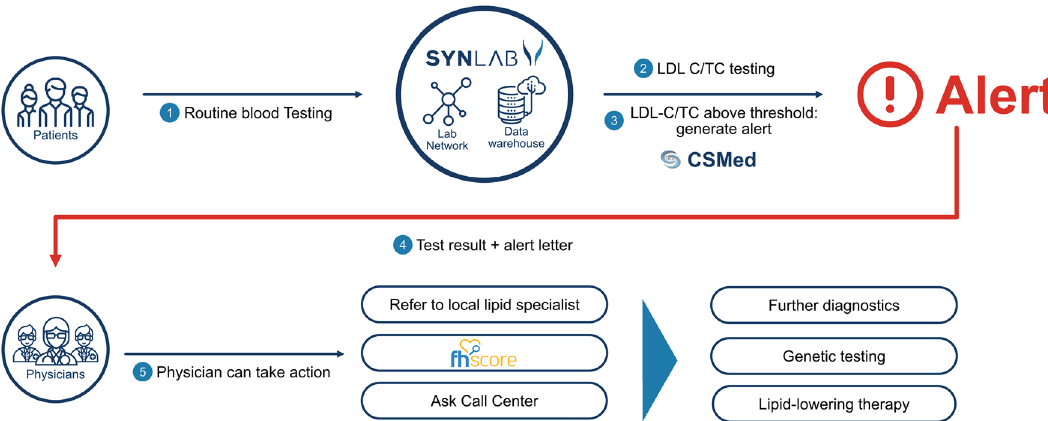
Figure 1. Schematic representation of procedures of FH ALERT. Alerting letters (ALs) were issued to treating physicians once total cholesterol (TC) or LDL-C scored above predefined threshold values. In addition to TC or LDL-C the ALs provided information about FH and further diagnostic options including genetic